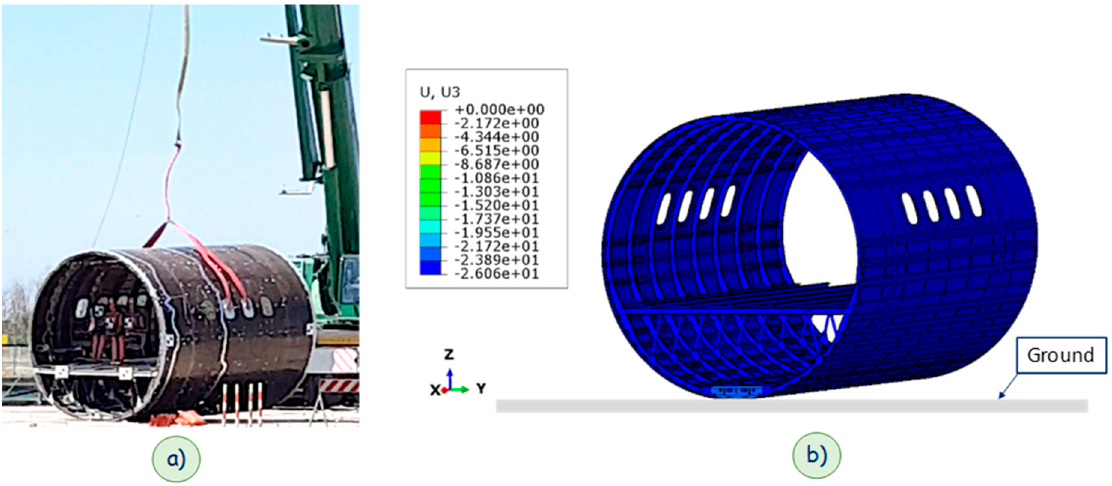
Figure 7. First phase of the fuselage section impact with ground: ( a ) Experimental test; ( b ) numerical simulation (units in mm).